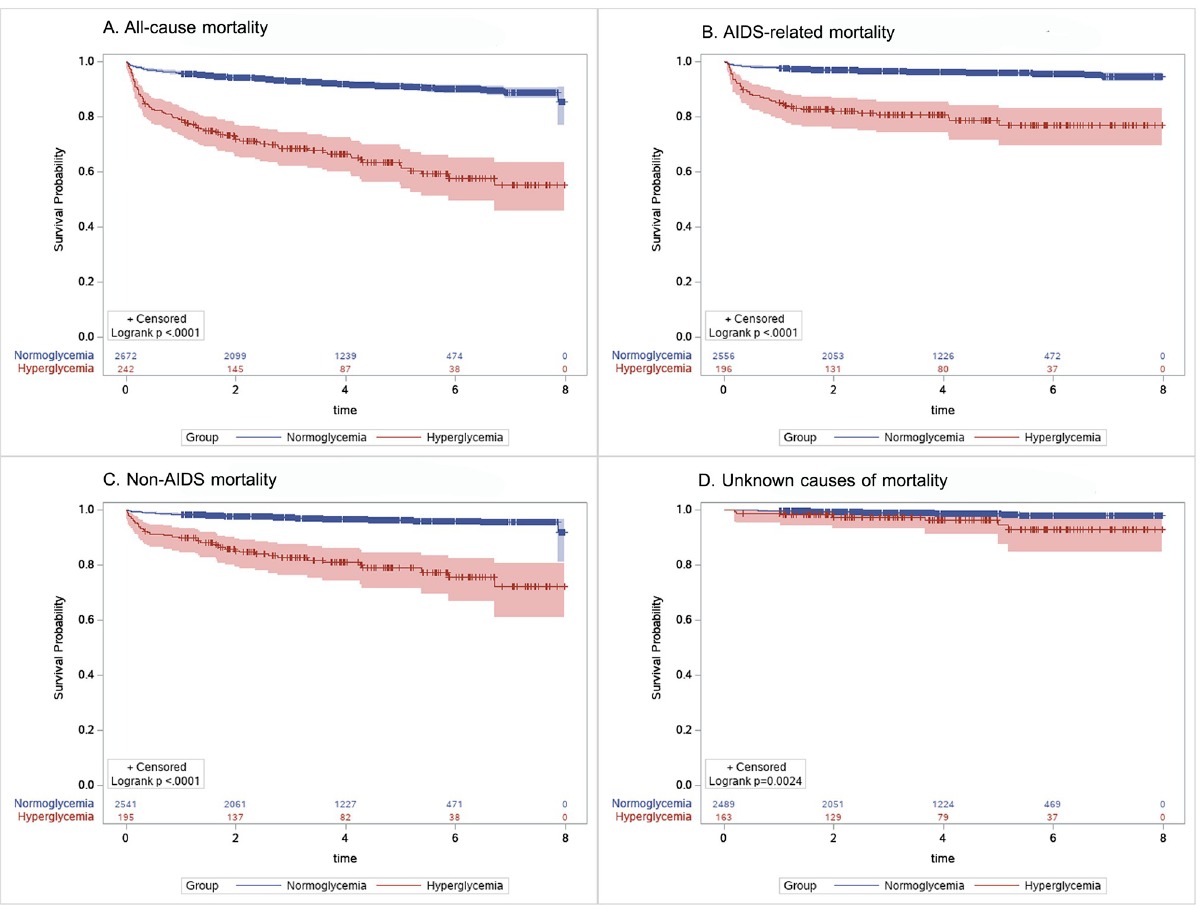
Fig 1. Kaplan-Meier survival estimates for all-cause and cause-specific mortality with number of participants at risk and 95% confidence intervals.